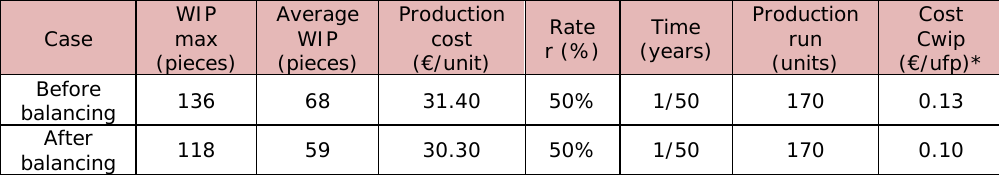
Table 8. “Calculation of the in-process inventory and its